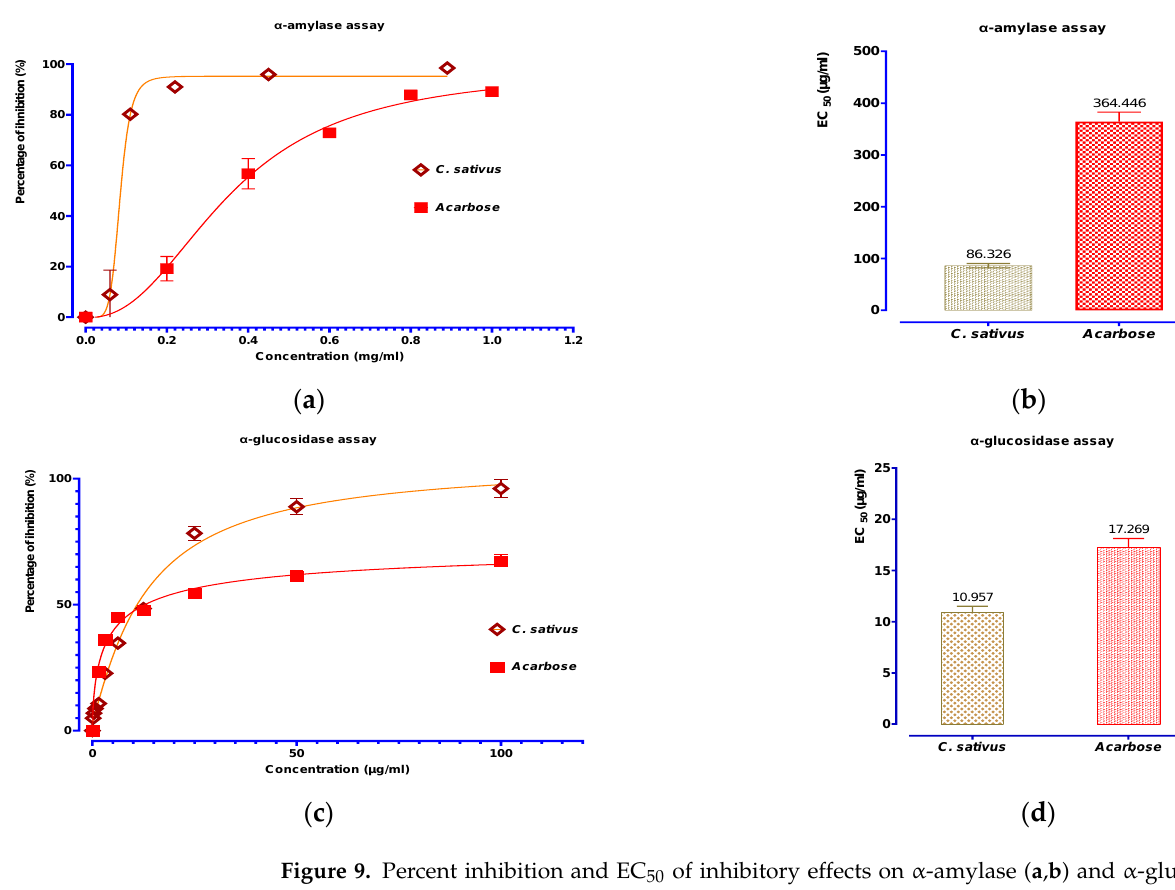
( b ) Figure 8. Effect of C. sativus decocted extract (E 0 ), normal control (NC), and heparin on prothrombin time ( a ) and partial thromboplastin time ( b ). 2.9. Antidiabetic Activity 2.9.1. Evaluation of the Inhibitory Effect of Decocted Extract on the Activity of α -amylase and α -glucosidase, In Vitro Regarding the in vitro inhibition tests of α - amylase and α -glucosidase by aqueous extract of C. sativus , the results presented in Figure 9 show that the extract exerts a variable and dose-dependent inhibitory effect. C. sativus decocted extract as well as acarbose